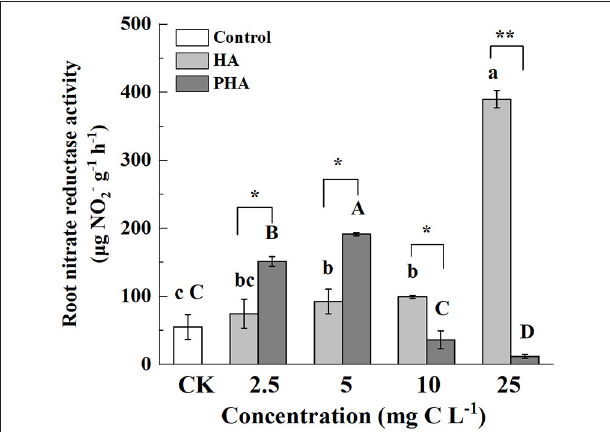
FIGURE 6 | A structural equation model to test the effects of root vigor, root PM H + -ATPase, and root nitrate reductase (NR) on nitrogen and phosphorus absorption. The width of the connections represents estimates of the standardized path coefficients, with solid lines representing a positive relationship and dashed lines a negative relationship. Significant connections are shown in red and non-significant connections in black. Significance was determined at: * P < 0.05, ** P <